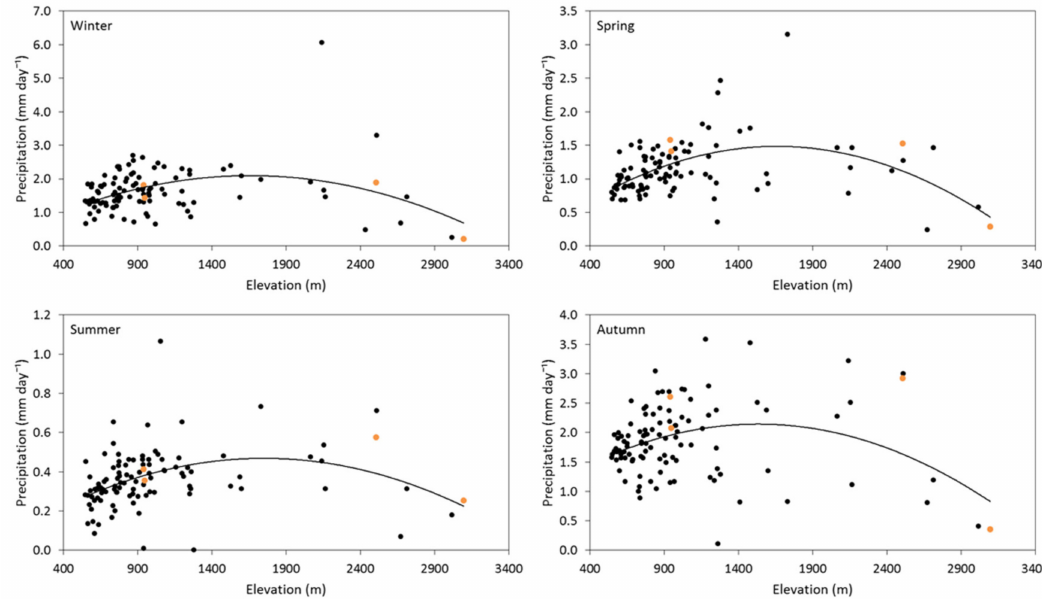
Figure 5. Trend of precipitation with elevation for the average year at seasonal scale. Orange dots represent gauges included in the Canales